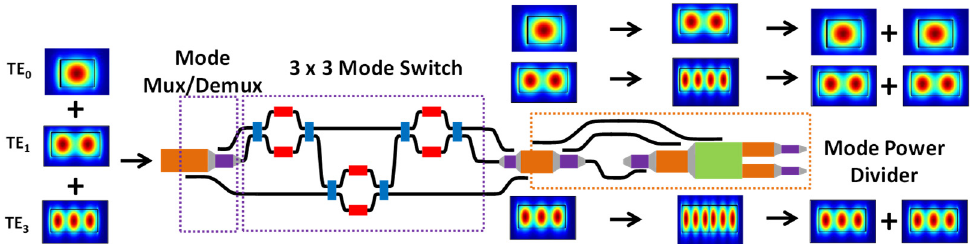
Figure 1. Design architecture of our proposed wideband and channel switchable MDM optical power divider. Insets: cross sections of different orders of MDM modes.